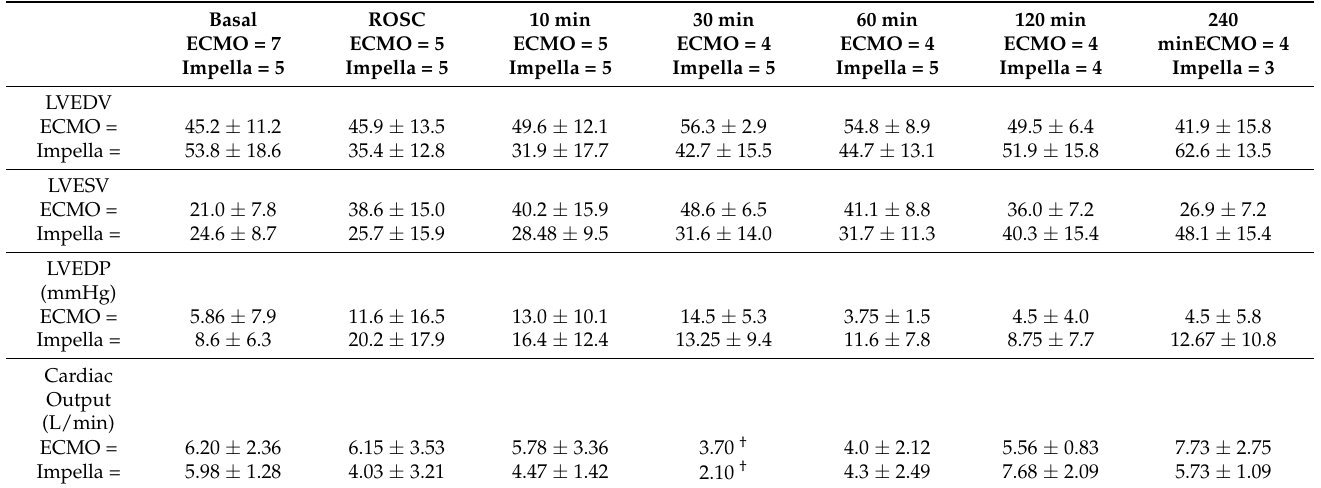
Table 2. Myocardial function